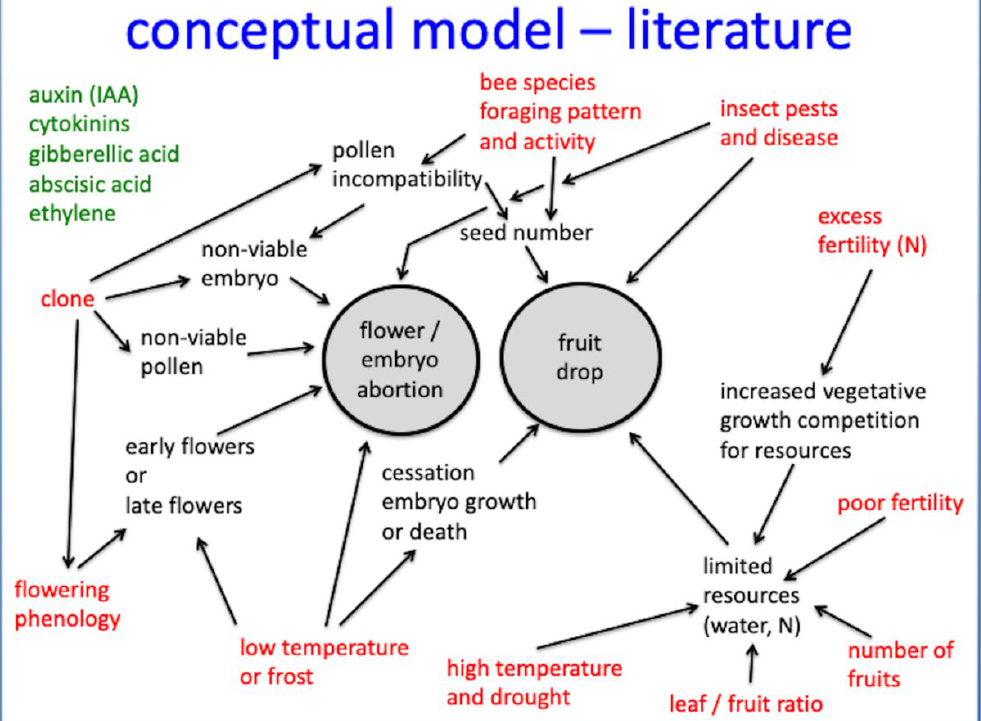
Figure 1. A conceptual model for fruit drop in wild blueberry. Relationships are based upon a review of more than 47 research studies [19]. Terms in red text are presumed major mechanisms that result in drop characterized either by abortion of flowers / embryos or by abscission of fruit (fruit drop). Green-colored text represents the plant hormones and bioactive plant growth regulating compounds that may be involved in the physiological mechanism of abortion of embryos or fruit drop.